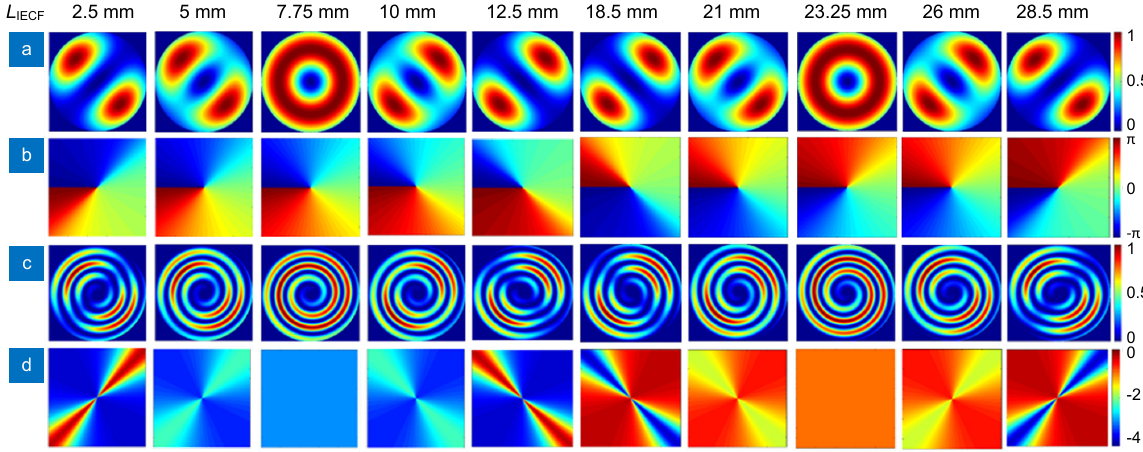
Fig. 6 | Intensity, phase, interference, and local helicity distributions of the OAM mode with TCs of / = ±1 generated by MSC 1 and IECF 1 at different values of L IECF